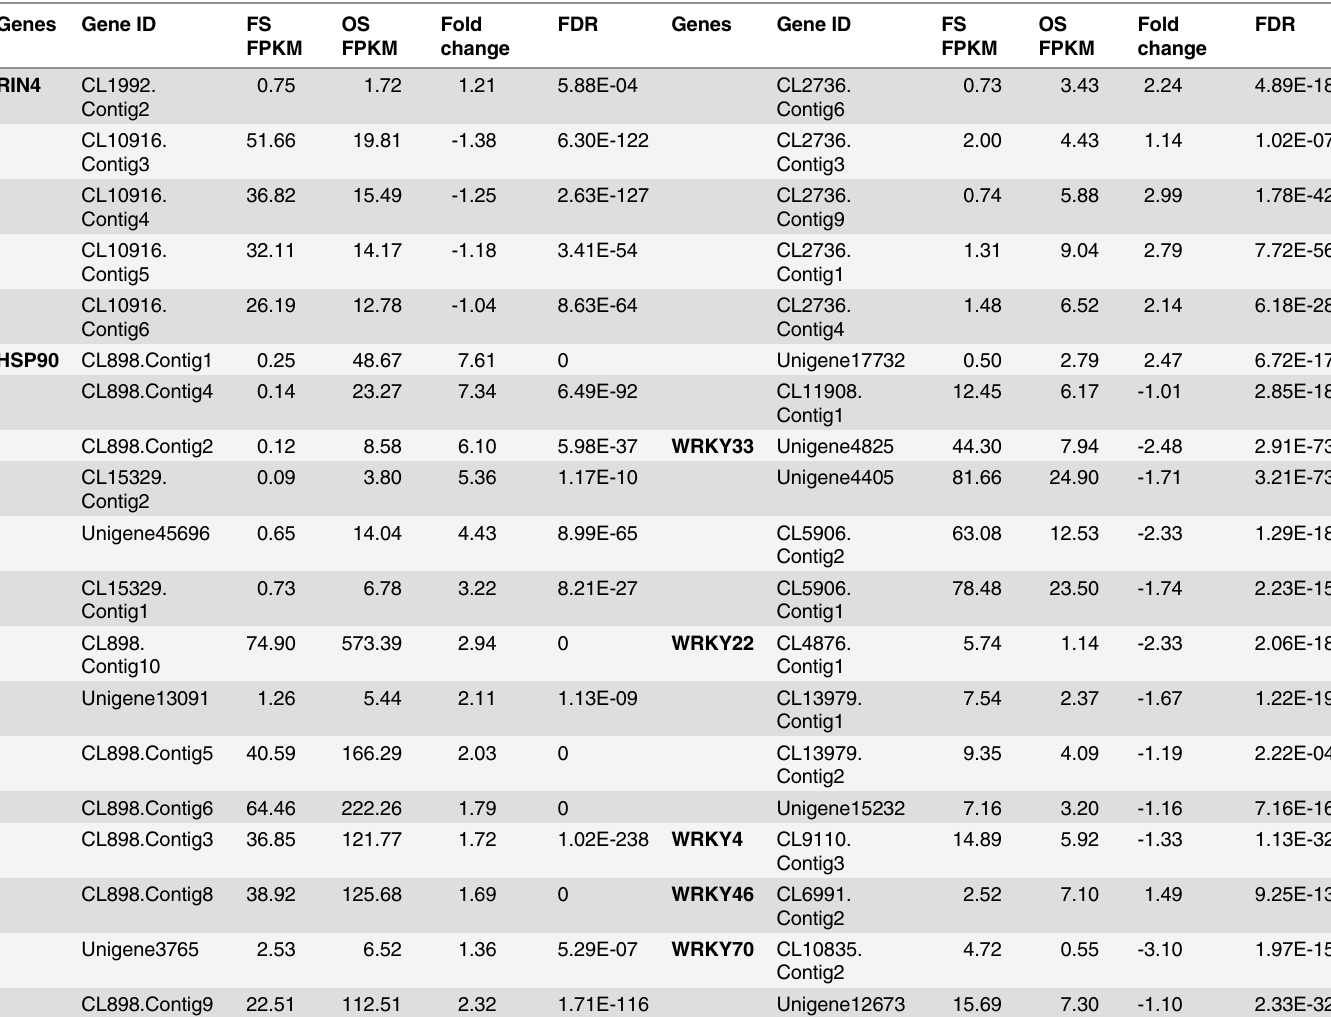
The pre fi x “ CL ” represents clusters, and “ unigene ” represents singletons. FPKM indicates the FPKM values of the unigenes in FS or OS. “ Fold change ” is equal to log 2 (OS-FPKM / FS-FPKM). “ + ” indicates upregulated transcription, and “ - ” represents downregulated